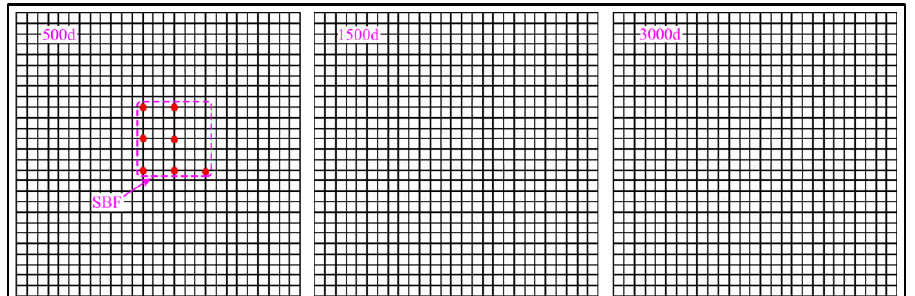
Figure 13. SBF of the laminates after the impact of 10 J.